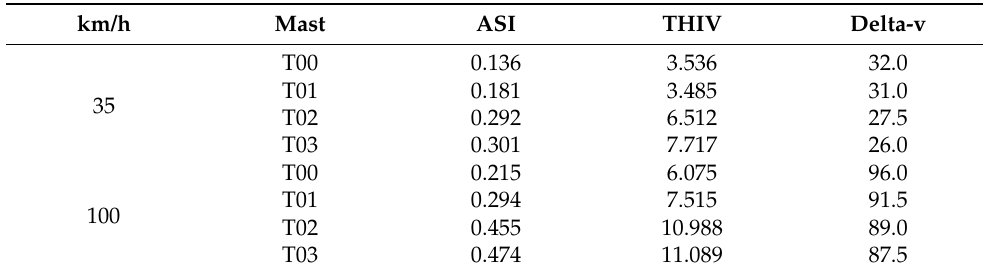
Table 5. The table of numerical test